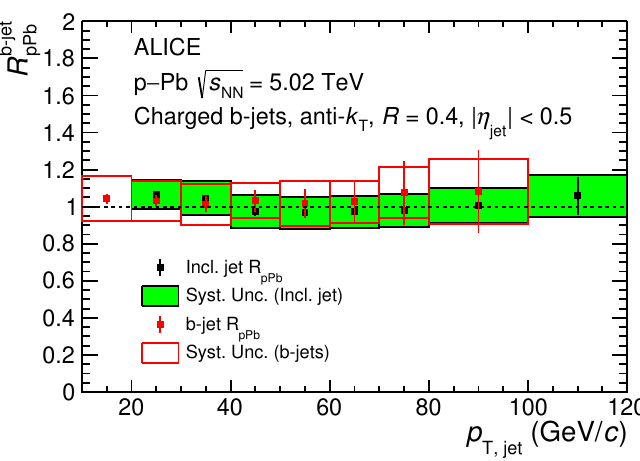
Figure 16. The nuclear modification factor of b jets compared to that of inclusive jets from ref. [82]. There is a global normalization uncertainty of 4 . 37% on the R b-jet calculation, and 11 . 6% on the inclusive-jet R pPb data due to luminosity calculation and the scaling of the pp